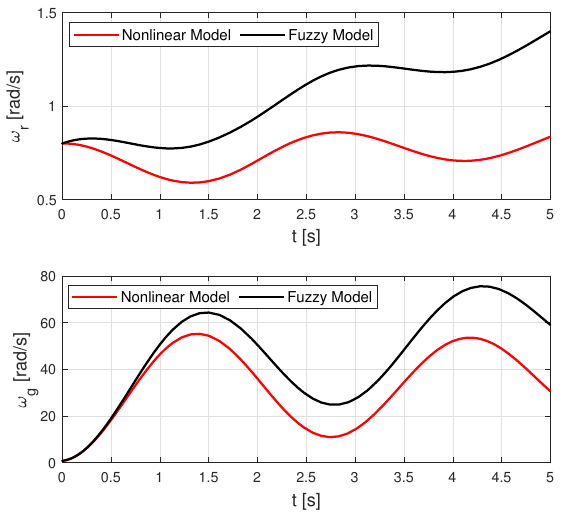
Figure 6. Angular velocity.